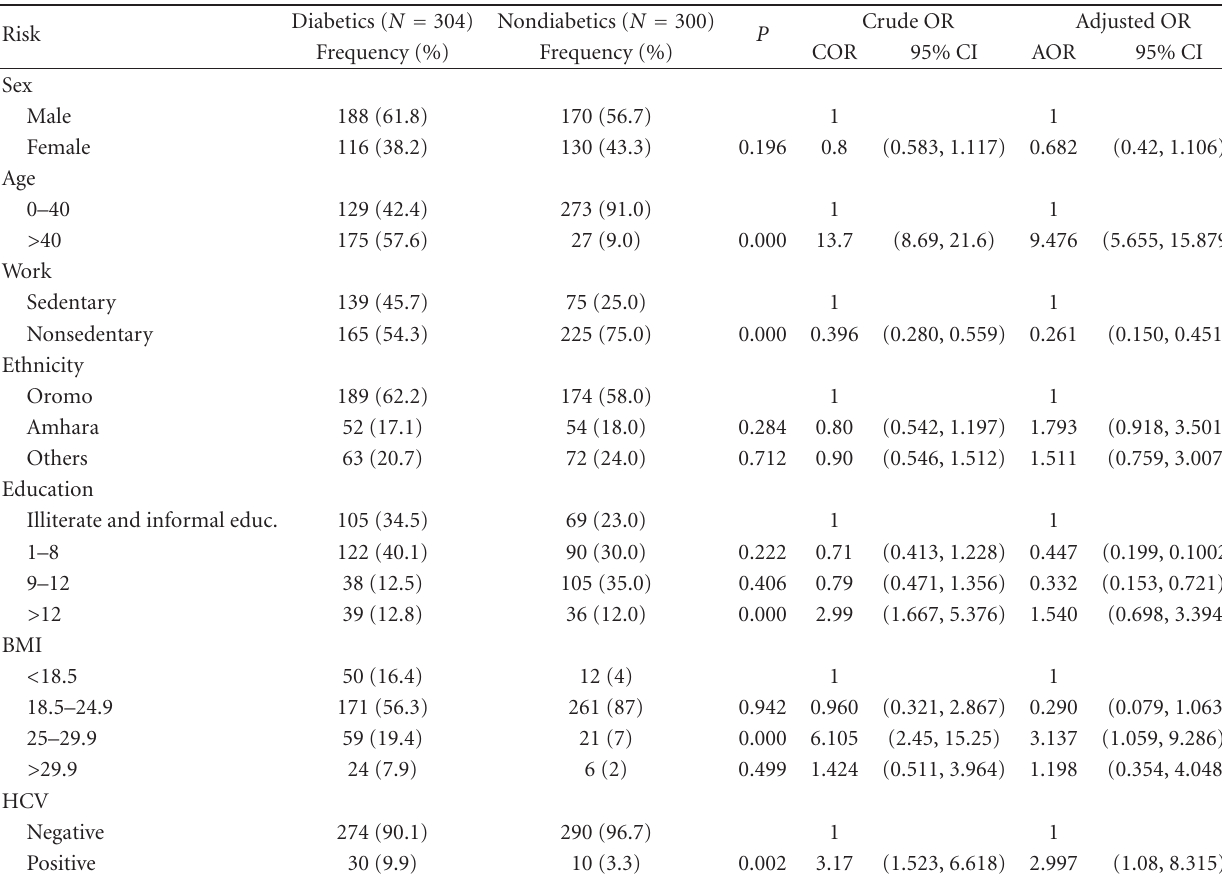
Table 1: Socio demographic and other risk factor variables distribution among diabetic and non diabetic study subjects, Jimma University Specialized Hospital,